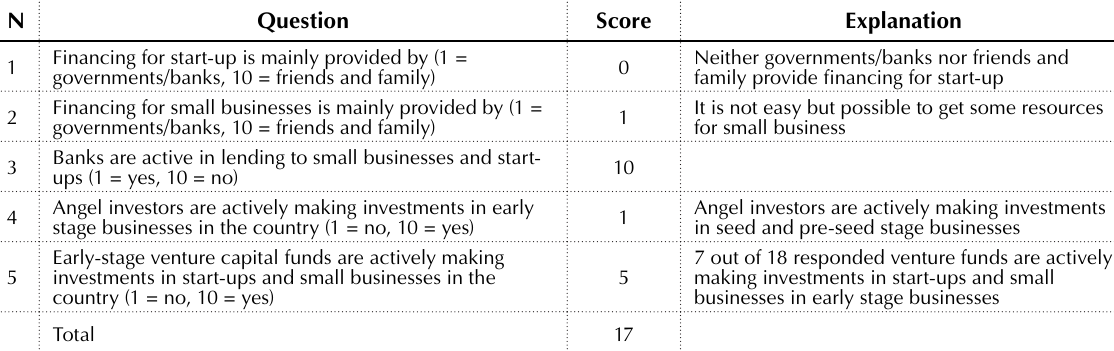
Table 6. Assessing a country’s readiness for crowdfunding: capital (D)